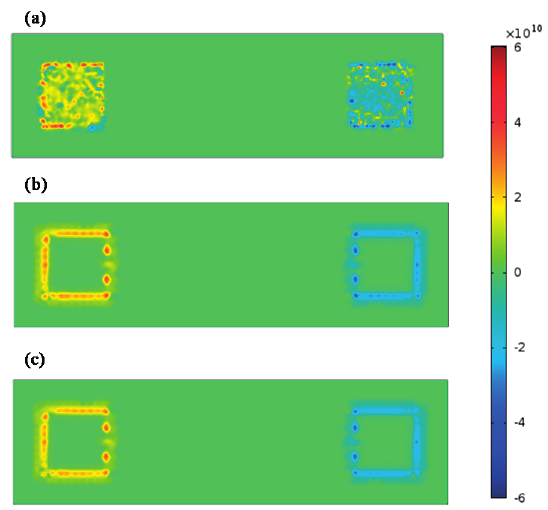
Figure 9. The electric field gradient at the depth of epidermis-dermis junction for dry textile electrode ( a ), wet textile electrode ( b ), and hydrogel electrode ( c ). In the figure, the anode electrode is located on the left side while the cathode electrode is located on the right